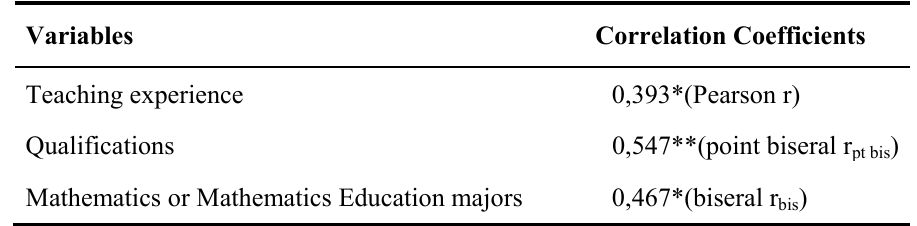
Table 2 : Correlations between students’